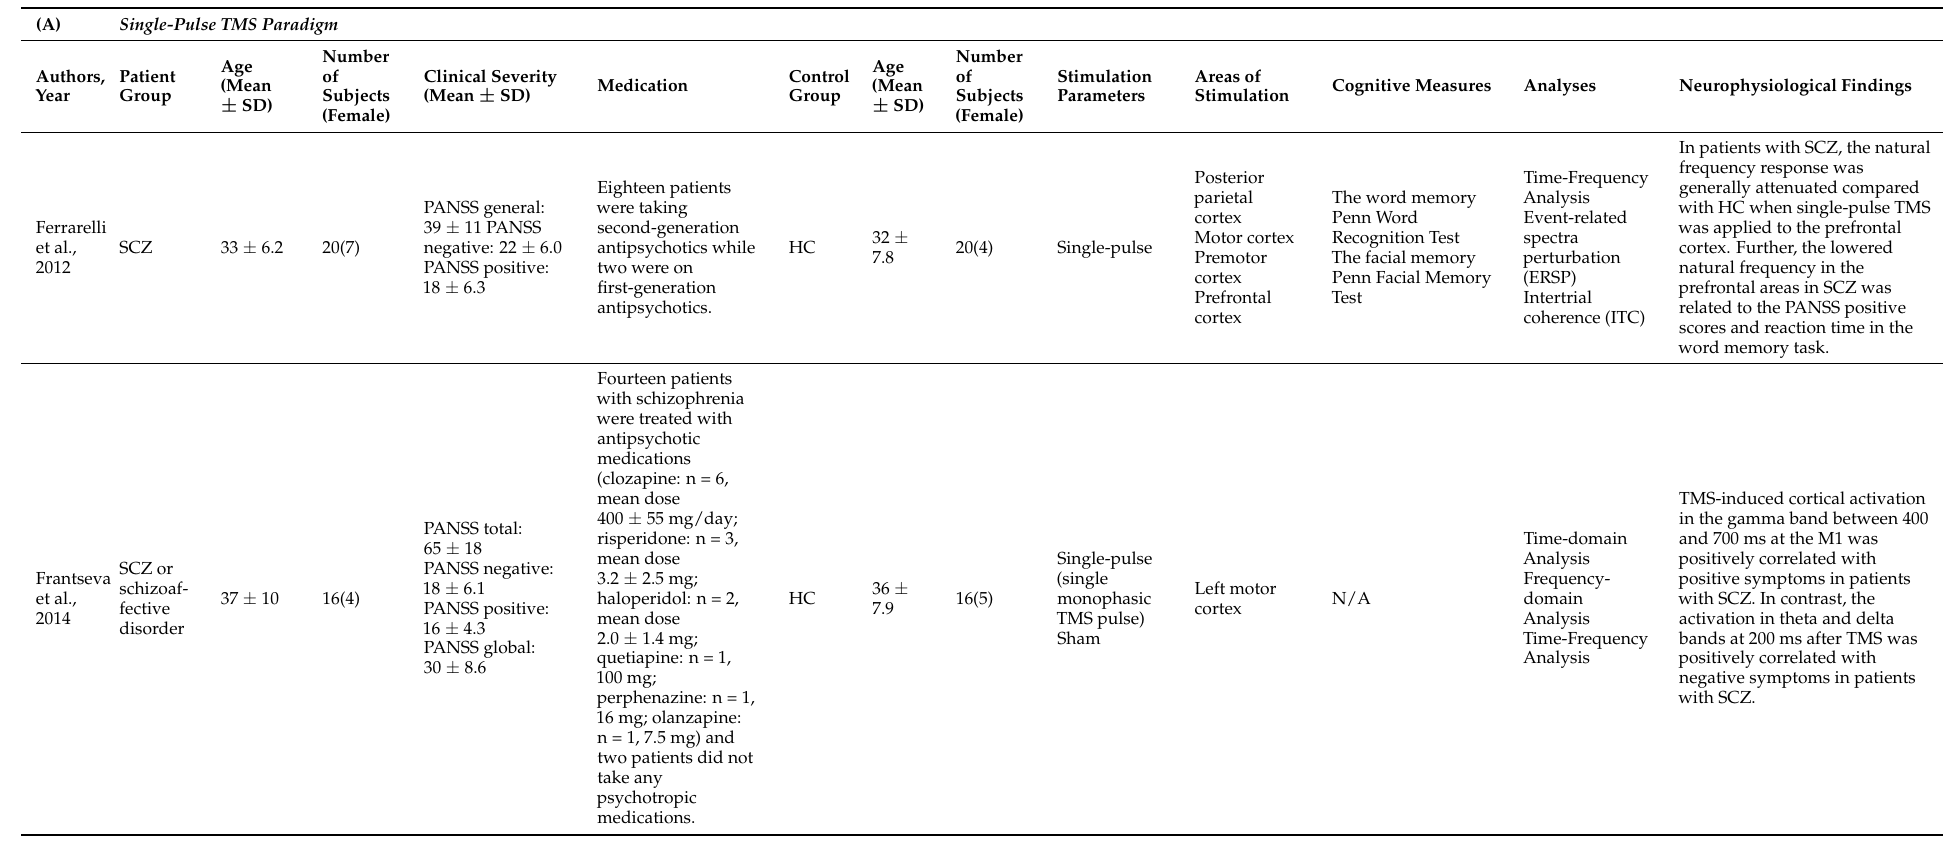
Table 2. Time-frequency